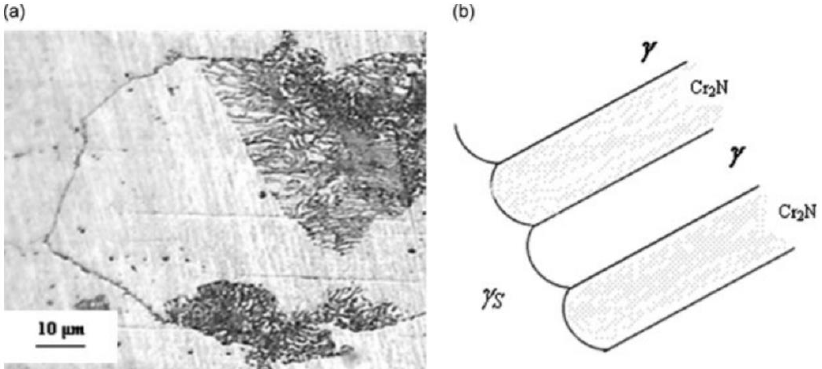
Figure 26. SEM image of partially transformed austenitic grain after 2 h at 850 °C ( a ) and a schematic of the structure ( b ) [40].